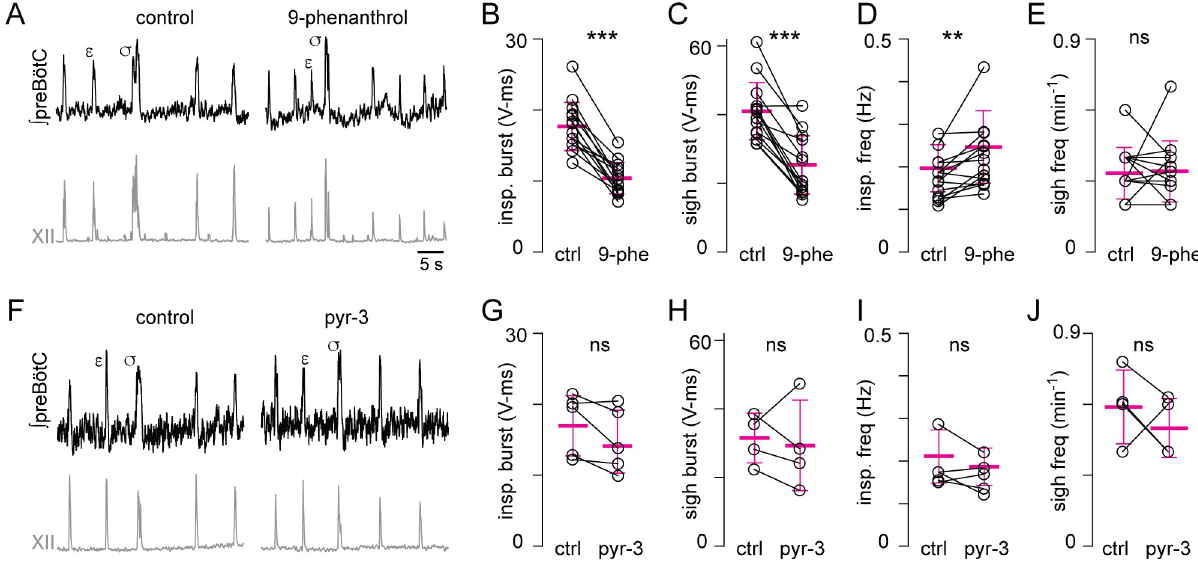
Fig 7. Trpm4 but not Trpc3 antagonists attenuate preBo¨tC rhythms in vitro. (A) preBo¨tC field potentials (black) and XII output (gray) in control and at steady state following approximately 20 min application of 100 μ M 9-phenanthrol in neonatal CD-1 mice. A typical eupnea-related inspiratory burst is marked with ε ; a typical sigh burst is marked with σ . (B–E) Area of inspiratory (B) and sigh (C) bursts as well as inspiratory (D) and sigh (E) frequency in control and 9-phenanthrol. (F) preBo¨tC field potentials (black) and XII output (gray) in control and at steady state following approximately 20 min application of 10 μ M pyr-3. Again, ε marks a eupnea-related inspiratory burst; σ marks a sigh burst. (G–J) Area of inspiratory (G) and sigh (H) bursts as well as inspiratory (I) and sigh (J) frequency in control and pyr-3. Mean ± SD shown (magenta) for all graphs in B–D and G– J. Primary data can be found in the Supporting information (S1 Data). preBo¨tC, pre-Bo¨tzinger complex; pyr-3, pyrazole-3; XII, hypoglossal nerve root.